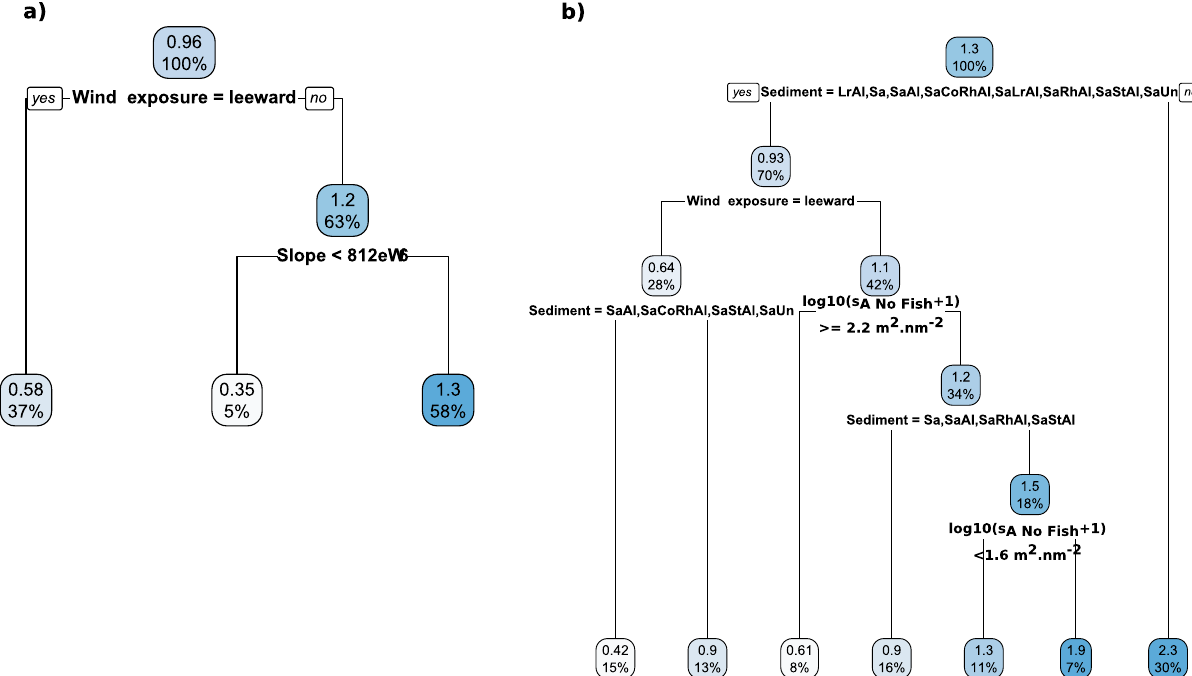
Figure 4. Regression tree on values of the fish-like acoustic biomass (log10(s A + 1)) performed on the complete data set ( a ) and the dataset limited to the locations where sediment was observed ( b ). The values inside the each leaf is the mean fish-like acoustic biomass (log10(s A + 1)) and the corresponding percentage of